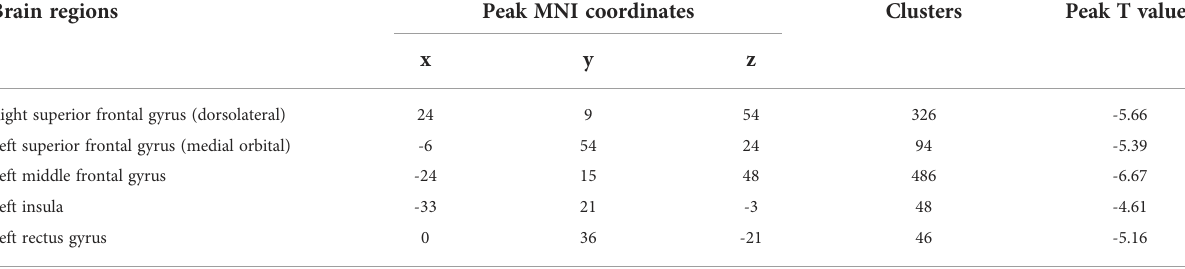
TABLE 3 Comparisons of ReHo values of brain regions in the AAL template between NSCLC patients received pemetrexed plus carboplatin chemotherapy and HCs. Brain regions